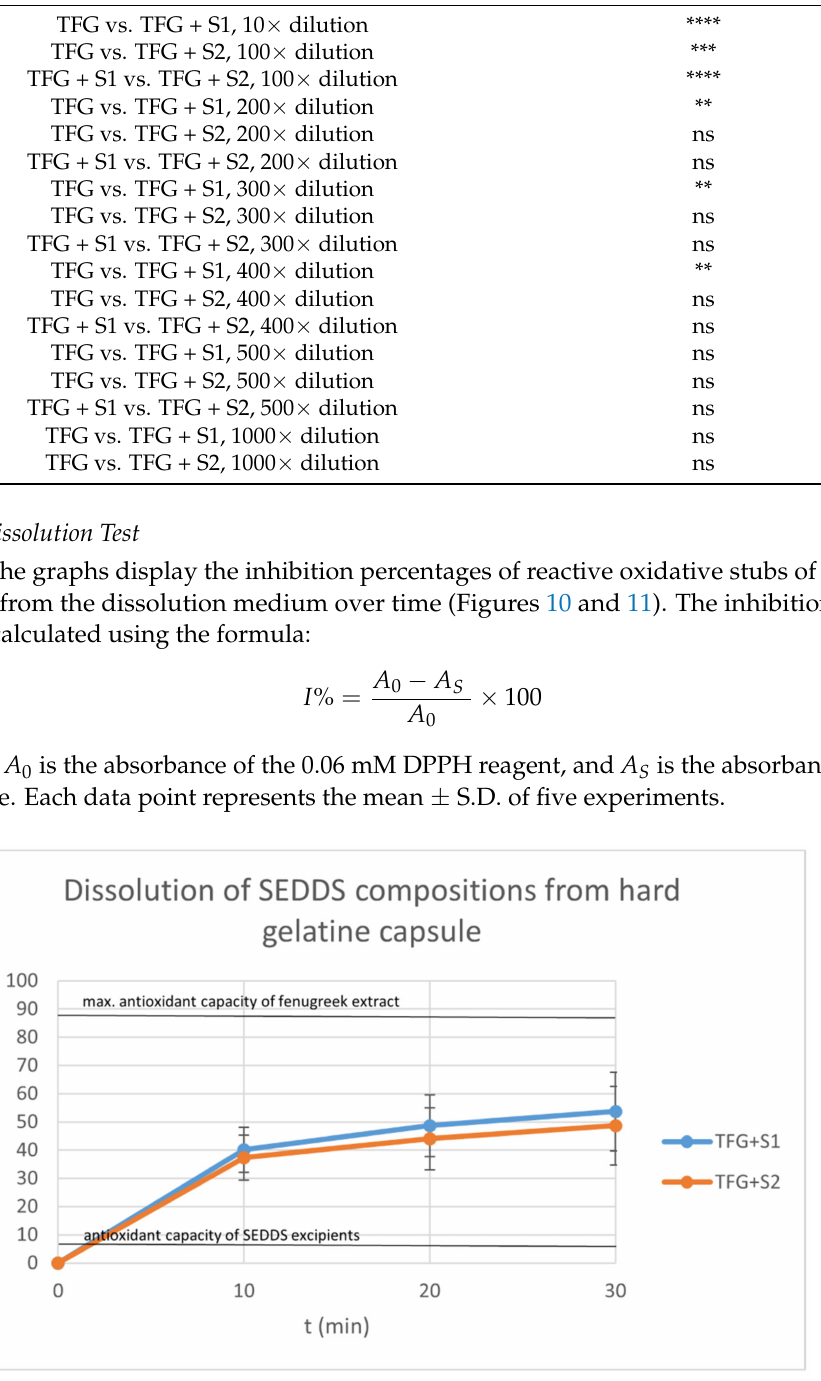
Figure 10. Dissolution of TFG + S1 and TFG + S2 from hard gelatin capsule over time. Each data point represents the mean ± S.D. inhibition percentage of 5 independent parallel dissolution test